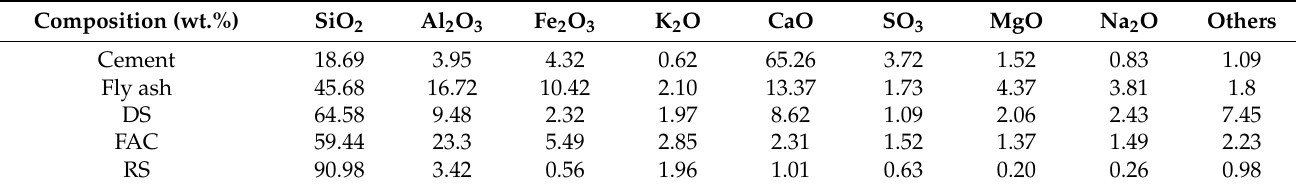
Table 1. The chemical compositions of the raw materials.